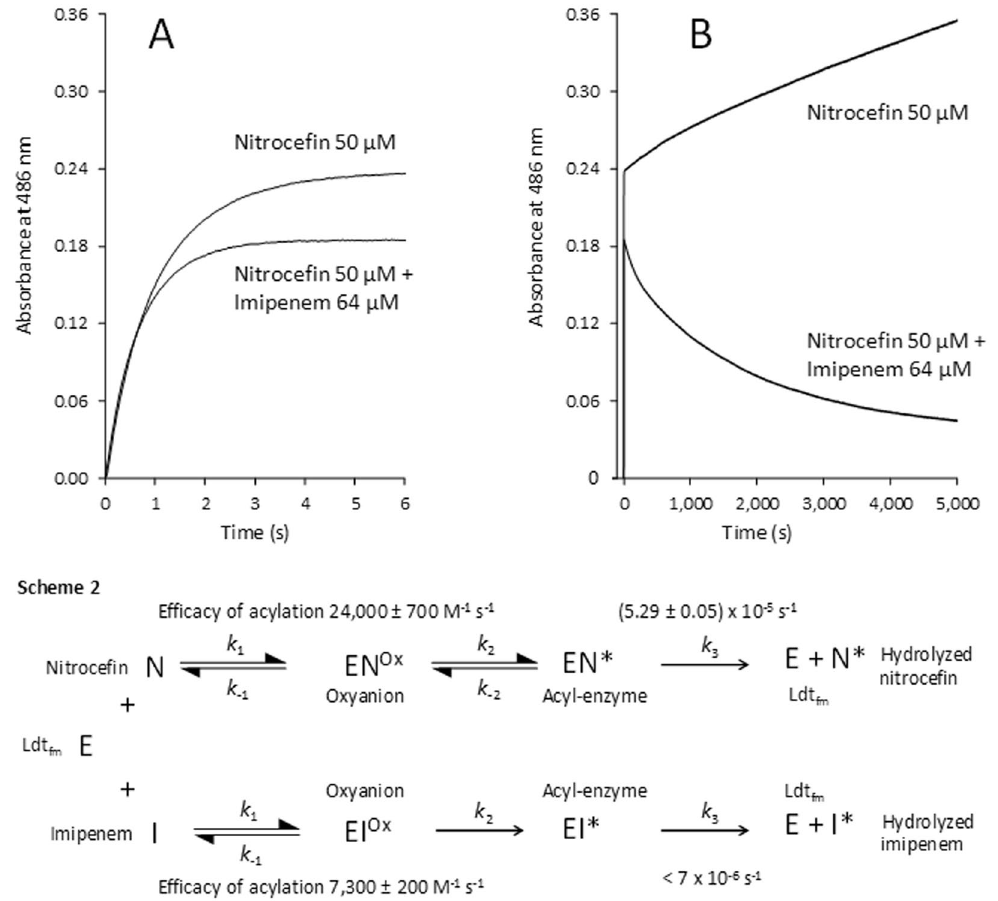
Figure 4. Competitive acylation of Ldt fm by nitrocefin and imipenem. One syringe of the stopped-flow apparatus contained nitrocefin (100 µ M) and imipenem (128 µ M) in 100 mM sodium phosphate buffer (pH 6.0). The second syringe contained Ldt fm (44 µ M) in the same buffer. Equal volumes from syringes 1 and 2 were injected into the cuvette of the spectrophotometer and the absorbance was recorded at 486 nm. Concentrations indicated in the Figure take into account the two-fold dilution. Panels A and B represent the same kinetics for two timescales (0–6 s and 0–5000 s, respectively). In panel a, the increase in the absorbance at 486 nm mainly results from the rupture of the β -lactam ring of nitrocefin upon acylation of Ldt fm . In panel B, further increase in the absorbance observed in the absence of imipenem (upper curve) results from slow hydrolysis of nitrocefin. In the presence of imipenem, recyclization of the β -lactam ring of nitrocefin accounts for the decrease in the